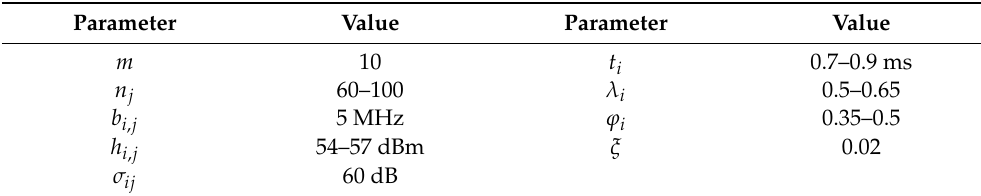
Table 2. The simulation parameters. m is the number of MEC servers, n j is the number of requesting vehicles covered by the j th server, b i , j , h i , j and σ ij are used to describe the current wireless channel environment, t i is the time delay tolerated by the vehicle v i , λ i and ϕ i are the weight parameters used to balance the energy consumption and resource cost of the requesting vehicles, and ξ is the weight parameter for the energy consumption of the MEC servers.